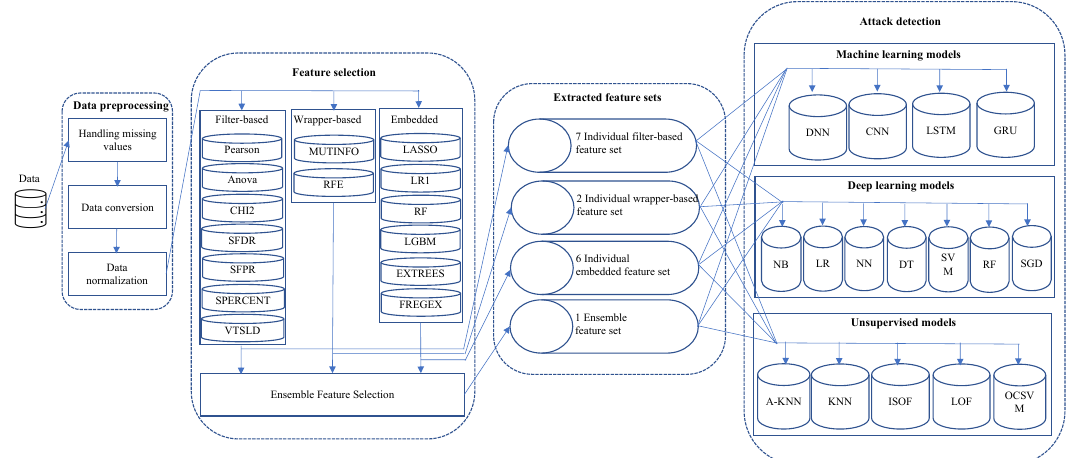
Figure 1. High-level framework of proposed methodology.